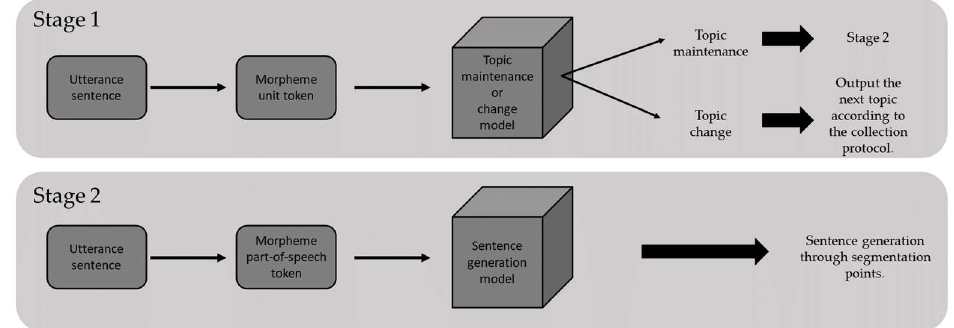
Figure 2. A flow with the two stages of the proposed method.